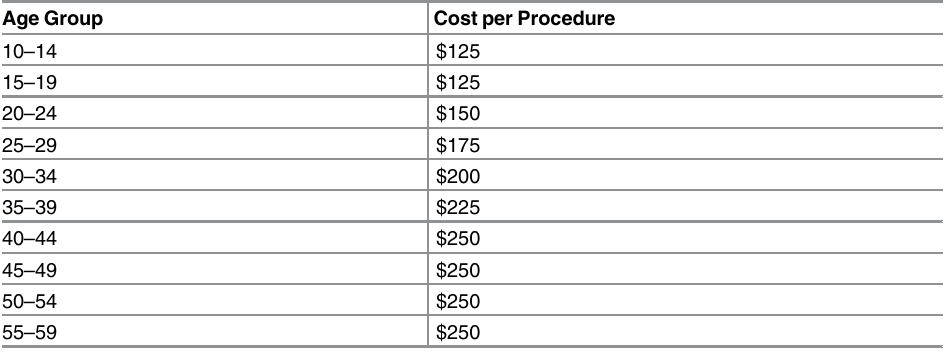
Table 3. Unit Costs of VMMC by Age Group, for Cost-Sensitivity